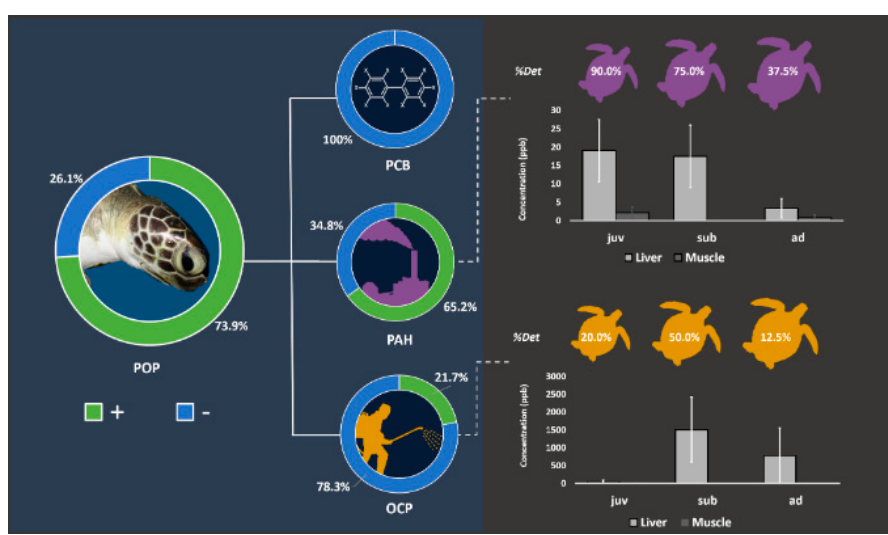
Figure 4. Percent frequency of detection of POPs and average levels in the tissues of green sea turtles Chelonia mydas. Adapted from Yaghmour et al. [7]. With the permission of Elsevier.